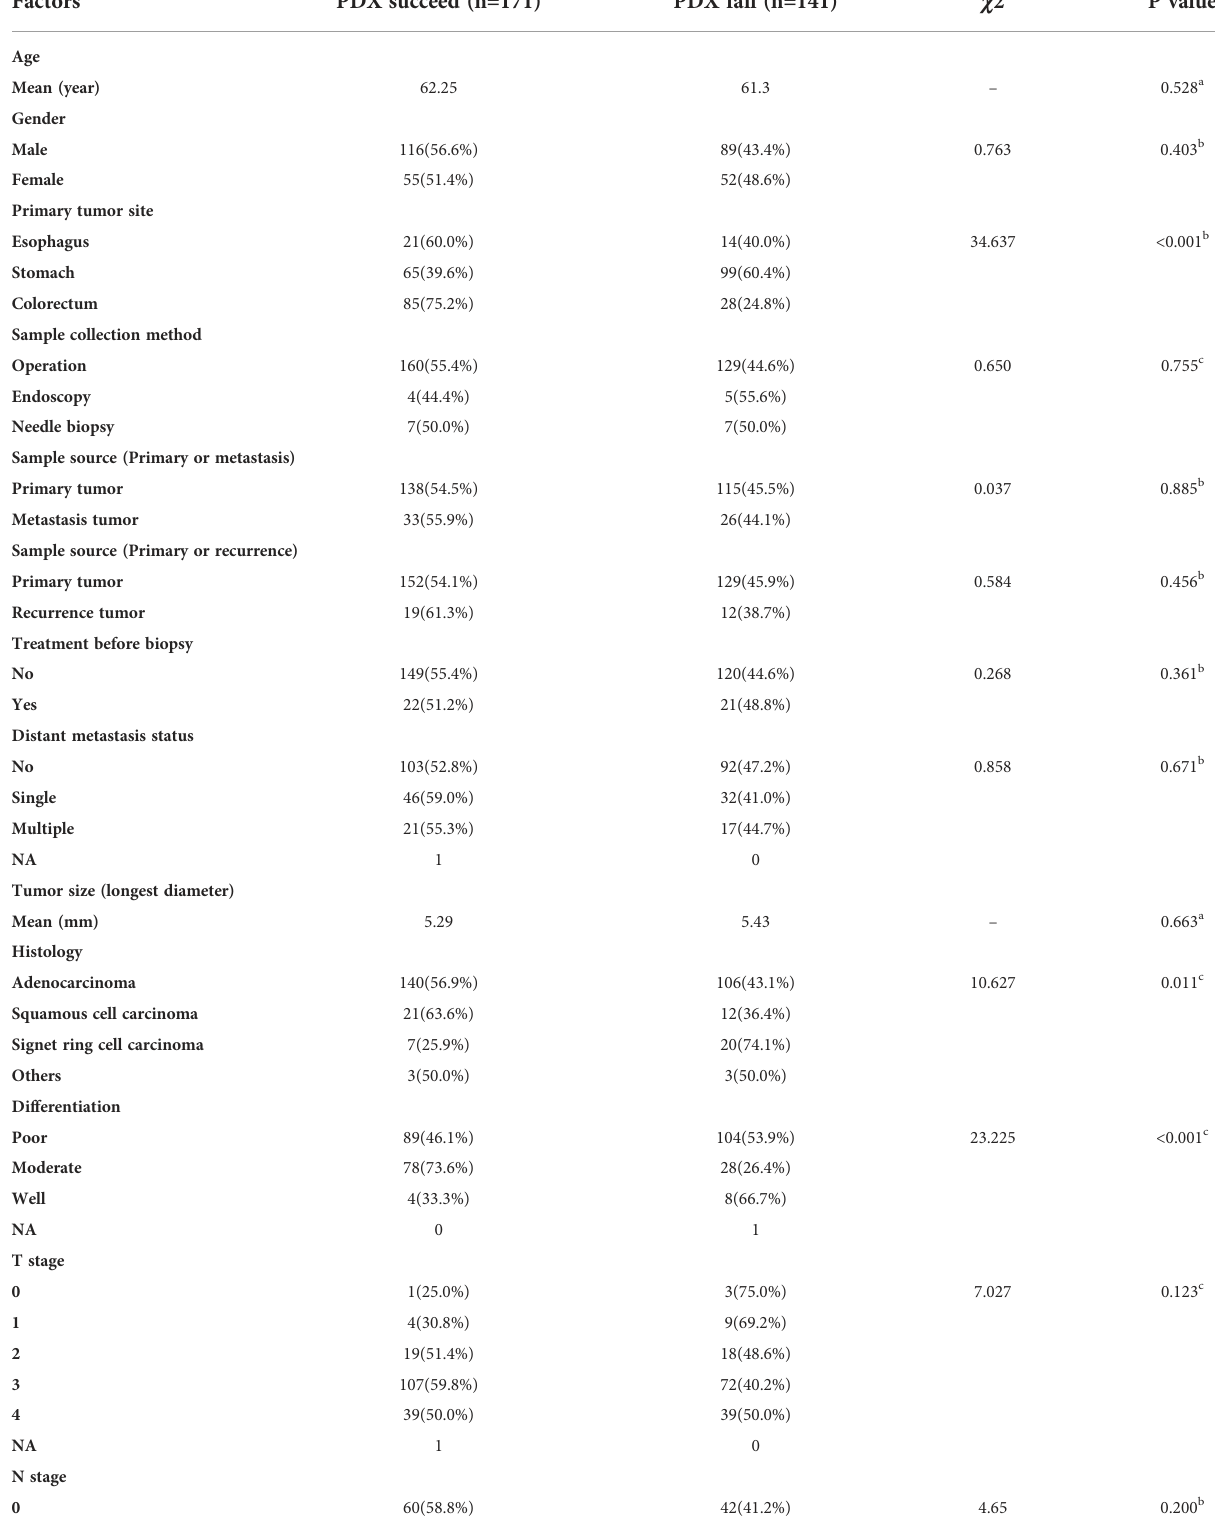
TABLE 1 Clinicopathological factors related to PDX